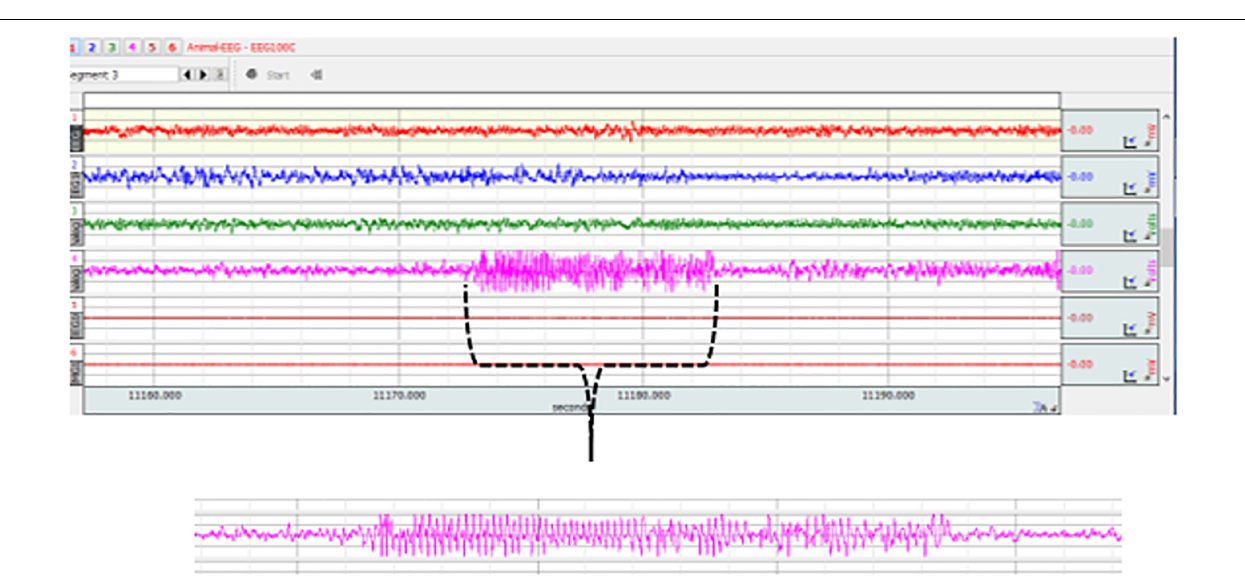
FIGURE 2 | Representative EEG recordings from TS (1), DTP (2), MS (3) and control (4) rats. 4th trace and expanded view shows a typical 7–10 Hz SWD lasting for approximately 10